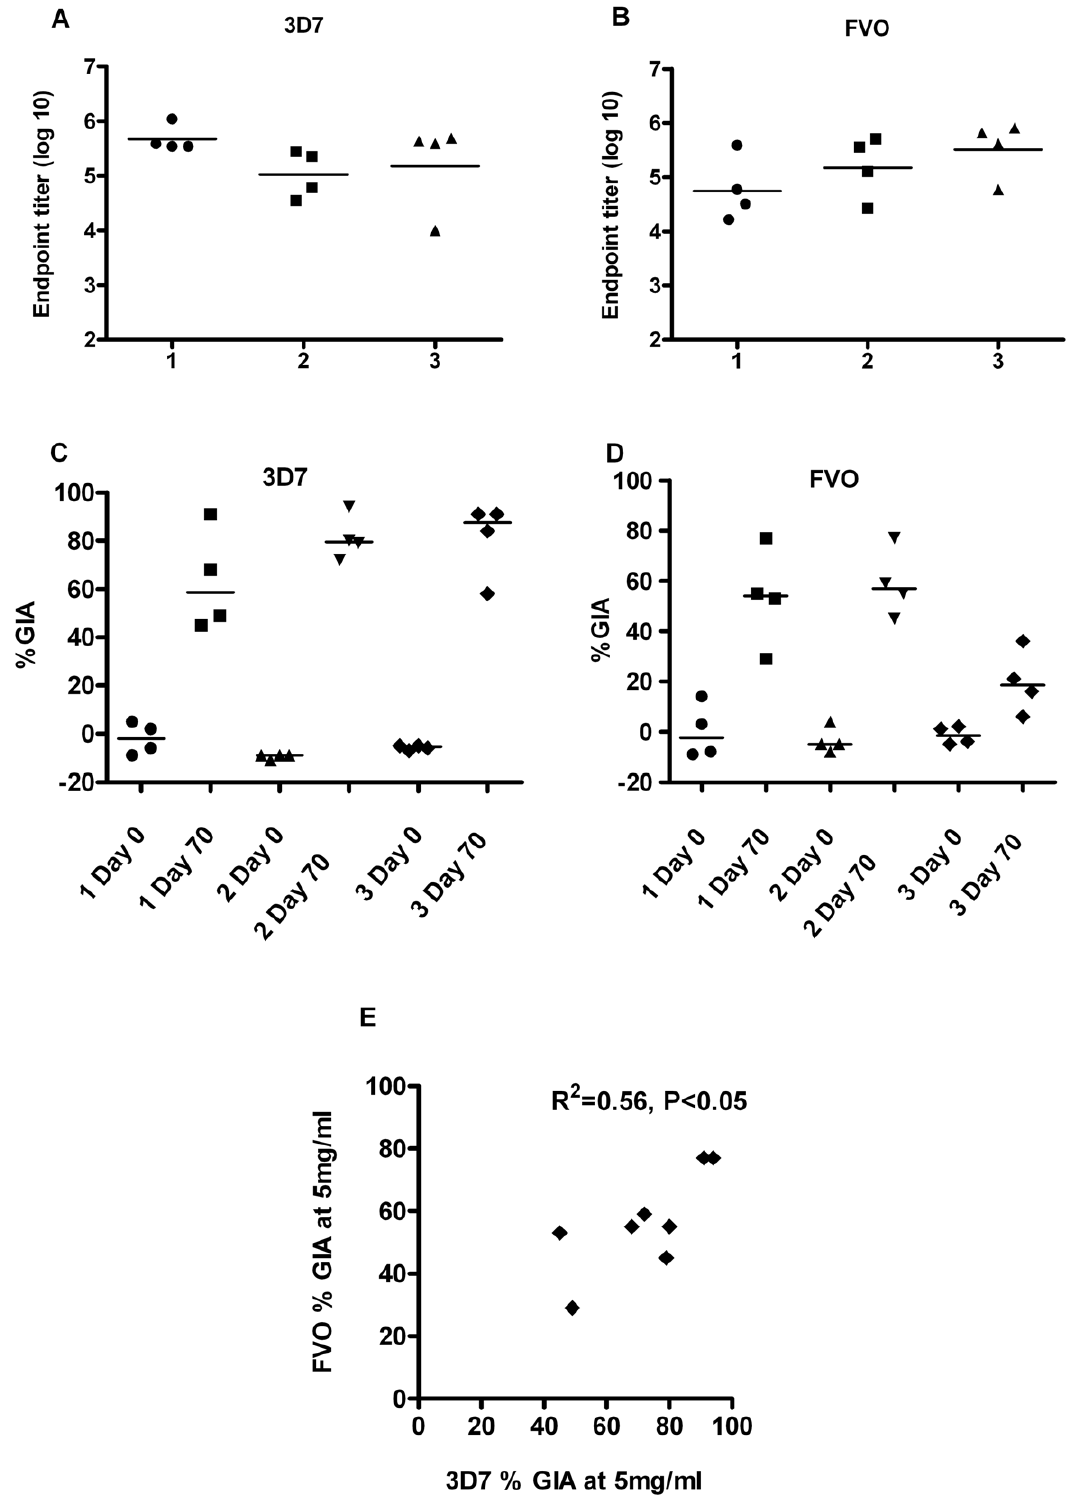
Figure 7. Comparison of antibody and growth inhibitory activity of rabbit IgG after vaccination with mono-allelic or bi-allelic PfAMA1 vaccines. New Zealand rabbits ( n =4) were primed with 1 6 10 10 vp 1) ChAd63-biallelic, 2) AdHu5-biallelic or 3) AdHu5-PfAMA1 (3D7). Groups 1) and 2) were boosted with 1 6 10 7 pfu of the bi-allelic MVA construct and group 3) was boosted with the mono-allelic MVA-PfAMA1 (3D7). The AMA1 specific antibody response against both homologous 3D7 (A) and FVO (B) PfAMA1 recombinant protein was measured in the serum two weeks after the final immunization (day 70). There was no significant difference in the antibody responses between the groups against the 3D7 or FVO alleles. The % GIA values for individual rabbits and the median are shown against both the 3D7 (C) and FVO (D) strains at 5 mg/ml IgG concentration. There was a significant positive correlation between the 3D7 and FVO GIA (R 2 =0.56, * P # 0.05) (E).